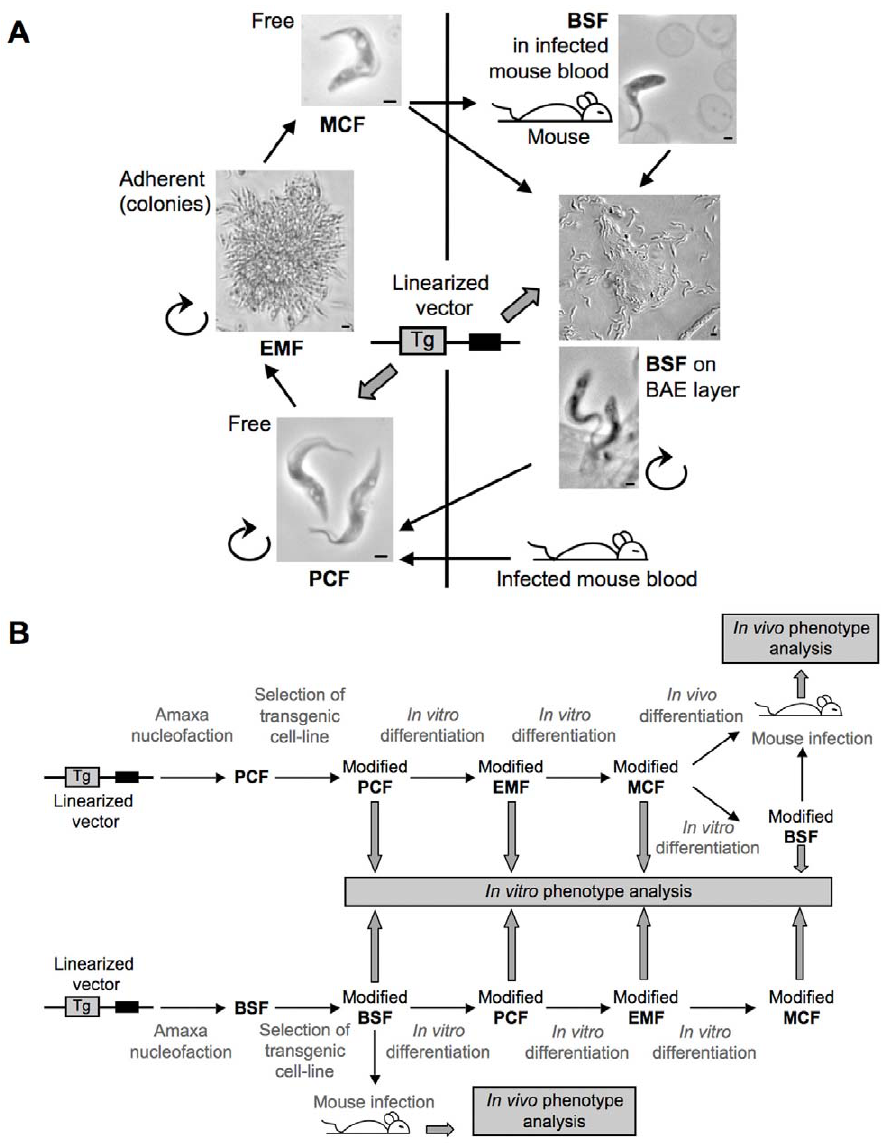
Figure 6. Invitro culture system and genetic tools for T.congolense . A, The different developmental stages cultured in vitro are represented as individual cells for PCF and MCF as adherent cells forming colonies for EMF and on BAE layer for BSF. Scale bar=1 mm for PCF, MCF, BSF in infected mouse blood and the lower photo of BSF on BAE layer. PCF, EMF and BSF are dividing cells as represented by the rounded arrow. BSF differentiation can be achieved either by infection of mice and culture from blood or directly in vitro on BAE layer. B, Scheme of transgenic cell-line analysis through the cycle starting from PCF (top) or BSF (bottom) transfection. Linearized vectors used in transfection assays are represented by a line and two boxes, the black one represents the selection marker and the grey one represents the transgene (Tg).